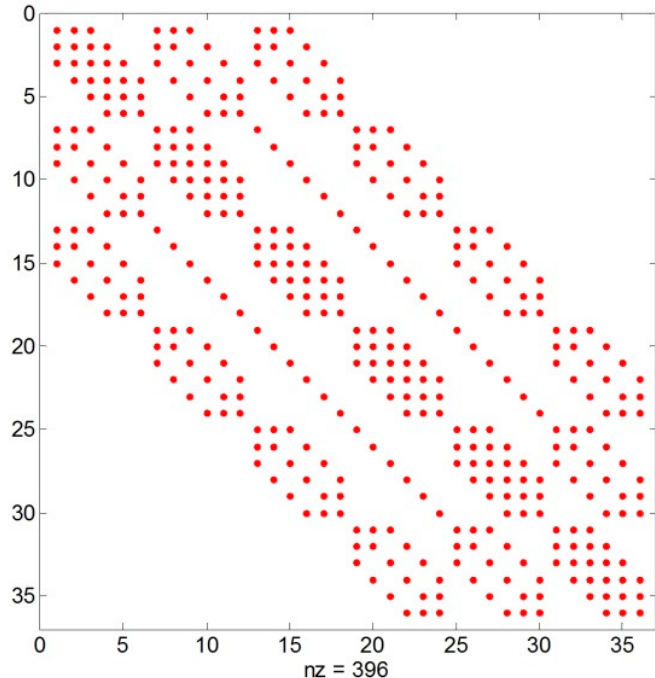
Figure 2. Nonzero elements of coefficient matrix A with the size of 36×36 (nz represents the number of nonzero elements).